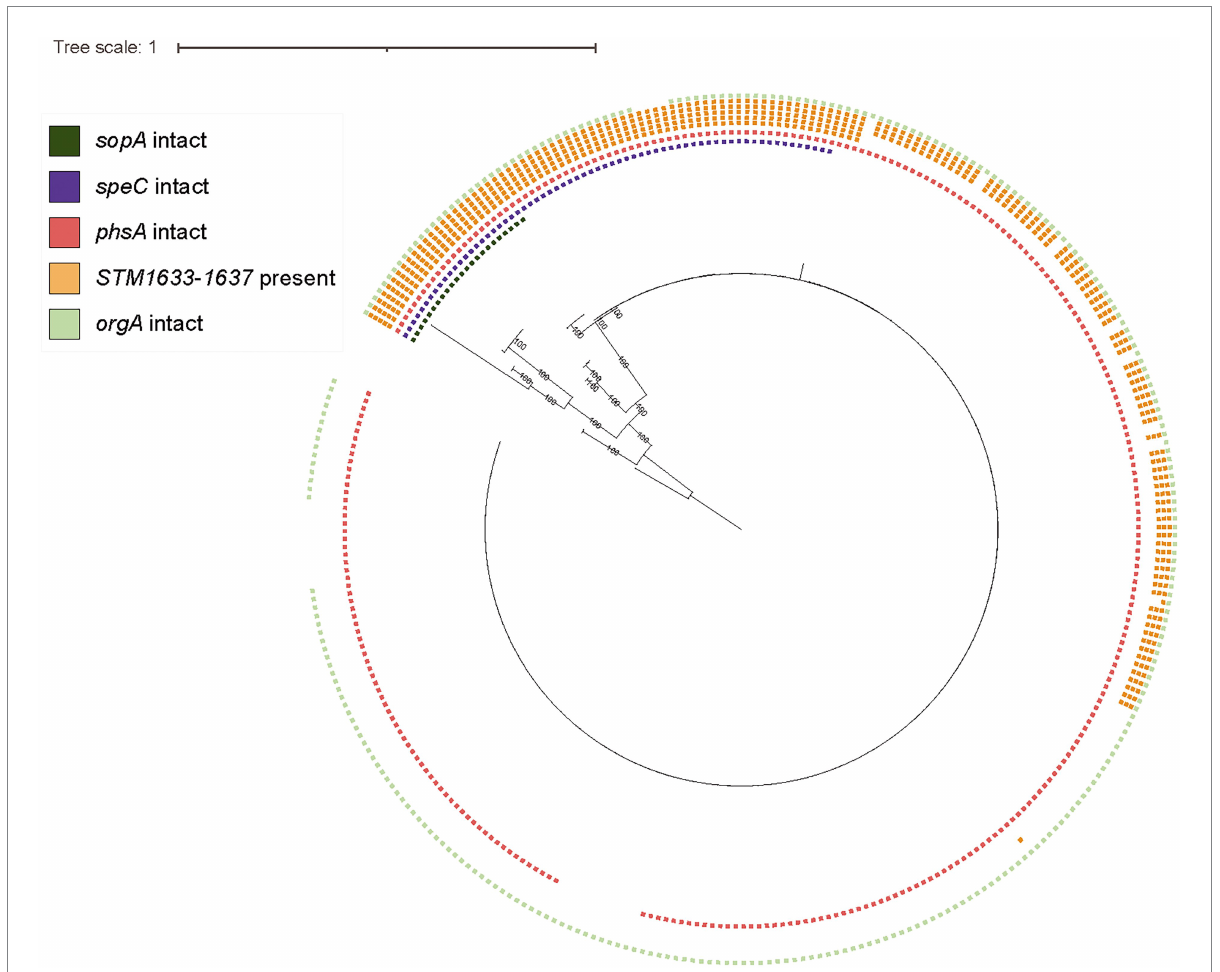
FIGURE 4 S. Cerro displays clade-specific PMSCs in sopA and speC, while loss of intact phsA, orgA , and STM1633-1637 coincides with emergence of subclades within the ST367 clade. Maximum likelihood phylogenetic tree constructed from core SNPs for representative isolates of section Typhi S. Cerro SNP clusters and a previously published set of S. Cerro isolates (Kovac et al., 2017); S. Orion GCA_003874655 was used as an outgroup to root the phylogeny as it shares a most recent common ancestor with section Typhi S. Cerro. Squares shown to the right of the phylogeny represent the presence of intact sopA (dark green), speC (purple), phsA (red), STM1633-1637 (orange; each square represents one gene), and orgA (light green), which are specifically shown because this and previous work (Rodriguez-Rivera et al., 2014; Kovac et al., 2017) have identified these loci as being associated with adaptation of S. Cerro to